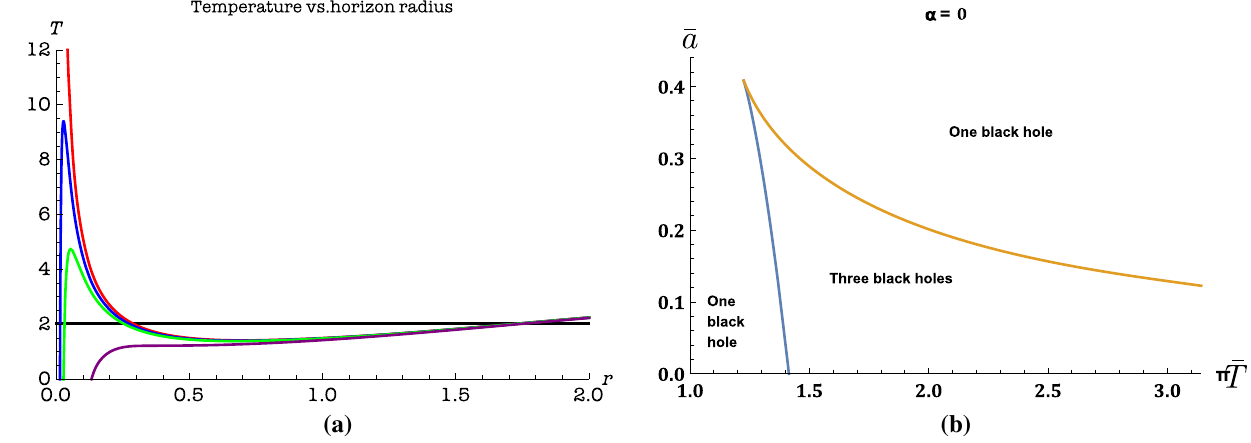
Fig. 1 Both the graphs are for ¯ α = 0. a Temperature ¯ T vs. scaled horizon radius ¯ r and b string cloud density ¯ a vs. temperature π ¯